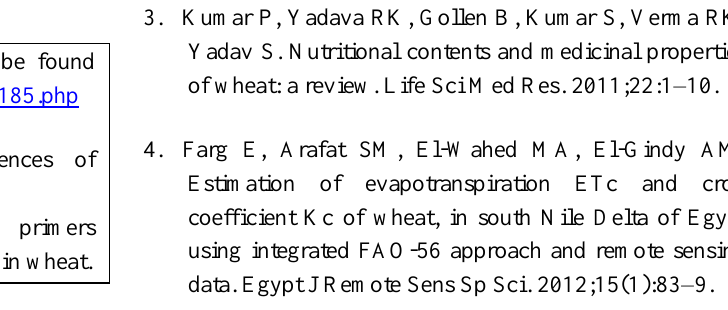
Figure 5: The ratio heat map for redundancy site identification of different restriction enzymes, where red and blue squares represent high and low rate of RE digestion sites,